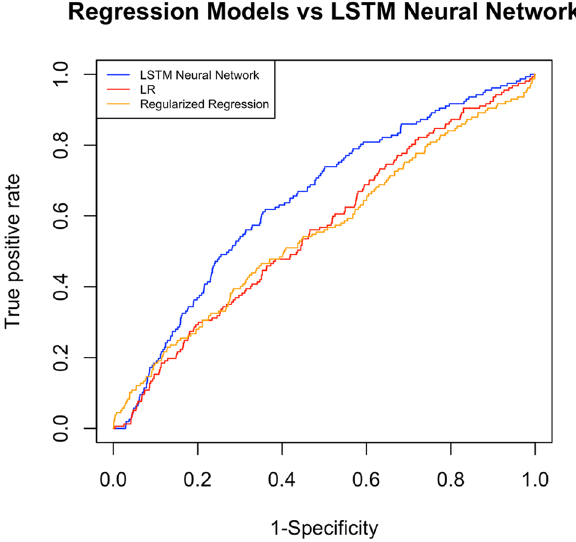
Figure 3. Comparison on external validation of the overall Area Under the Receiver Operating Curve (AUROC) as a measure of performance of the Long-Short Term Memory (LSTM) Neural Network model, discrete time Logistic Regression (LR), and regression with elastic net penalty.